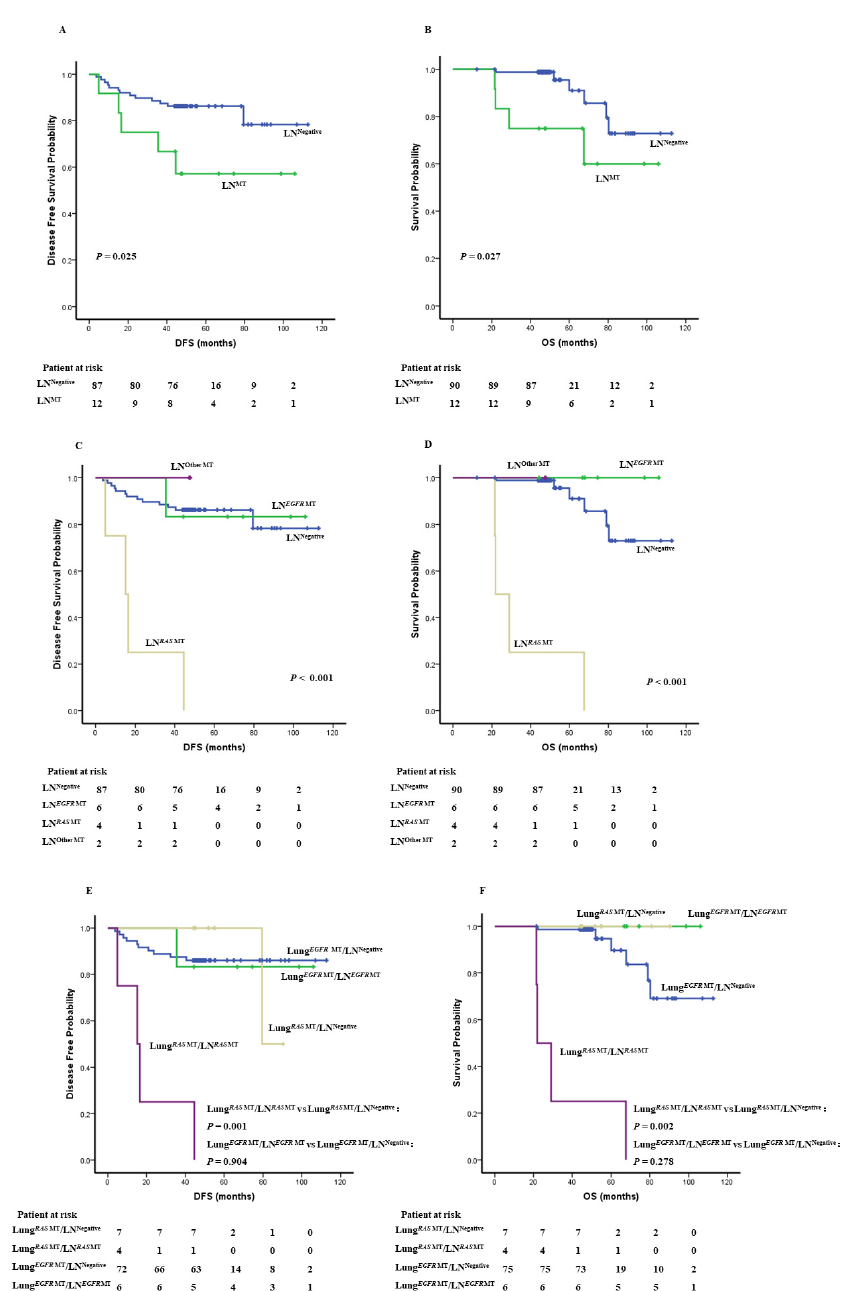
Figure 3. Survival of 102 histologically stage I LUAD with or without molecular alterations in